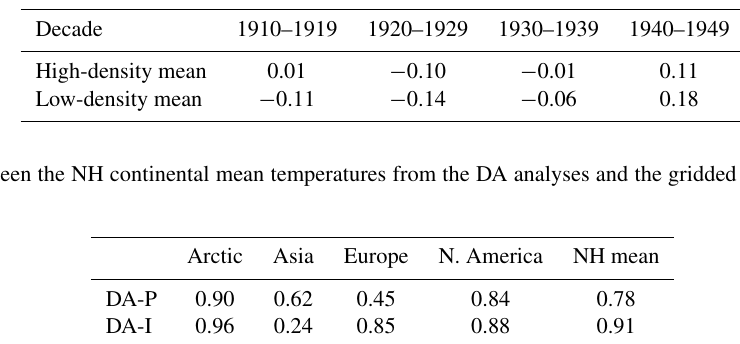
Table 1. Decadal winter mean temperatures (anomalies with respect to the 1850–1949 AD mean) for the high- and low-density coverage of Asia in HadCRUT3v, during the last 4 decades of the simulation period.